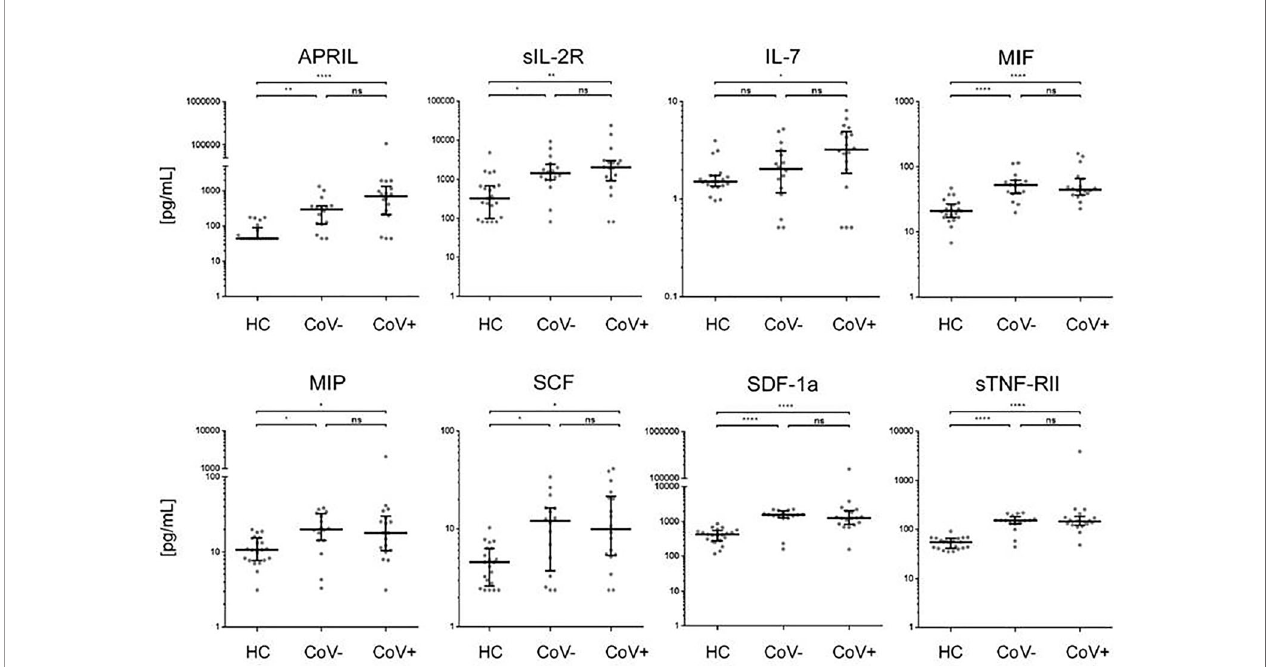
FIGURE 1 | Serum markers elevated in COVID-19- and COVID-19+ symptomatic patients compared to healthy controls. The indicated in fl ammatory markers were assessed by multiplex analysis from the serum of healthy control (HC) volunteers, symptomatic, COVID-19 negative tested patients (CoV-) and symptomatic, COVID- 19 positive tested patients (CoV+). For each marker, individual results are depicted as dot plots. Each point represents the median of two technical replicates of each individual. Data are shown on a logarithmic scale for better visualization. Data are shown as median and interquartile range 25%-75%. p > 0.05 = ns not signi fi cant; *p < 0.05, **p < 0.01, ****p < 0.0001, Group differences between the three cohorts were tested using Kruskal-Wallis-test in conjunction with Dunn ’ s multiple comparisons test using multiplicity adjusted calculation of p-values. (HC, n=21), (CoV-, n=16), (CoV+, n=18); APRIL, a proliferation-inducing ligand; sIL-2R-soluble interleukin 2 receptor; IL-7, interleukin 7; MIF, Macrophage migration inhibitory factor; MIP, macrophage in fl ammatory proteins; SCF, stem cell factor; SDF, 1a- stromal cell-derived factor 1; sTNF, RII-tumor necrosis factor